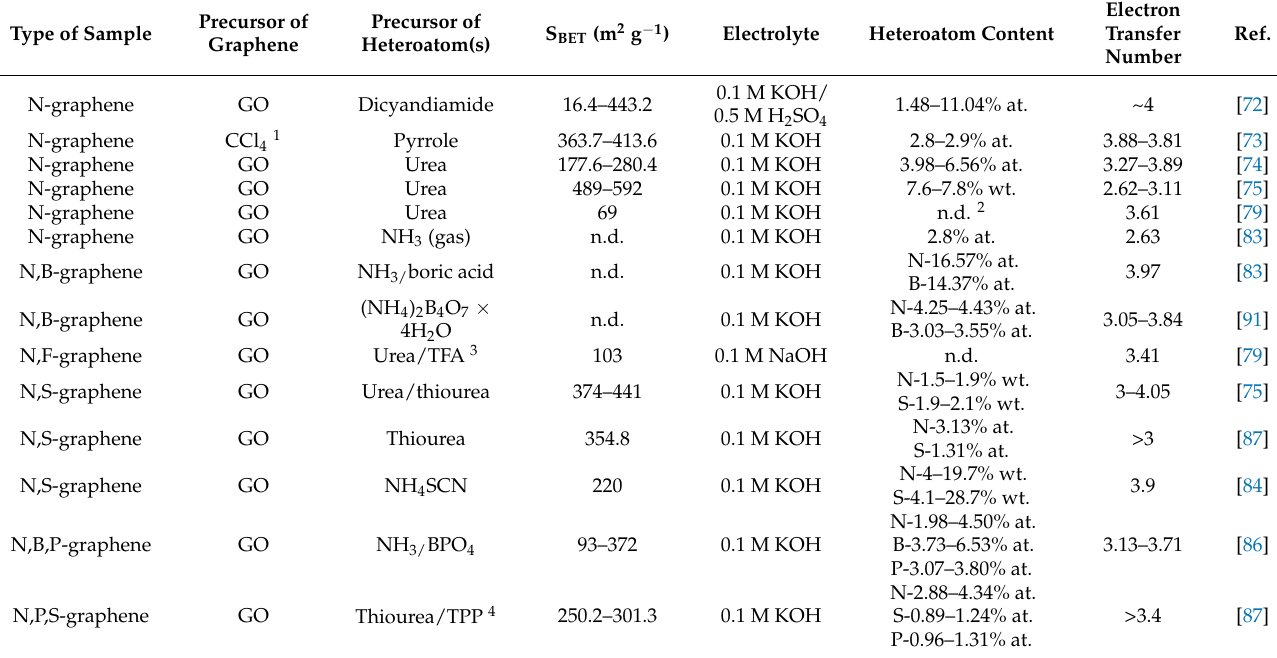
triphenylphosphine.